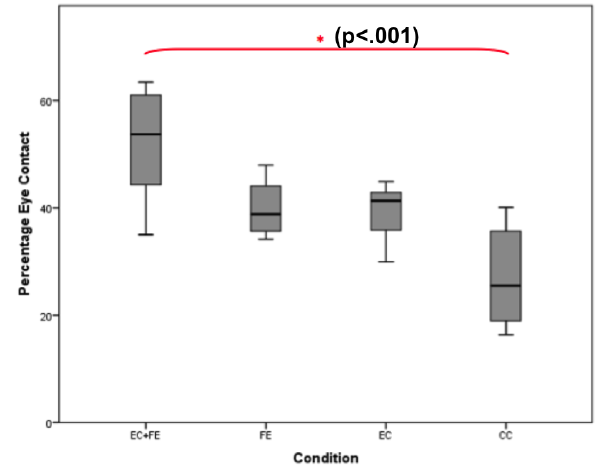
Figure 11: Time spent looking at the robot’s face, in percentage of the whole experiment time. * indicates significance ( p <0.001) between conditions FE+EC and CC